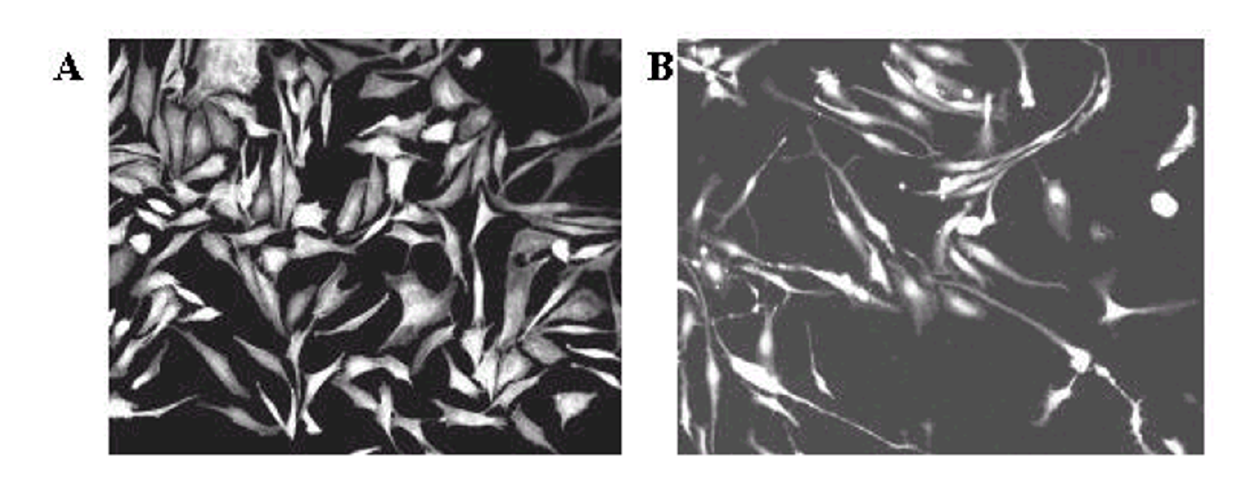
Figure 1 Resveratrol treatment produces elongation of BPAEC. Panel A. Example of stellar, cobblestone-like morphology characteristic of normal BPAECs grown in culture. Panel B. Example of elongated, spindle-shaped morphology characteristic of resveratrol- treated cells. Here cells were treated with 100 µ M resveratrol and were viewed with 20X objective. Six experiments, each involving a different preparation of BPAEC, were performed with similar